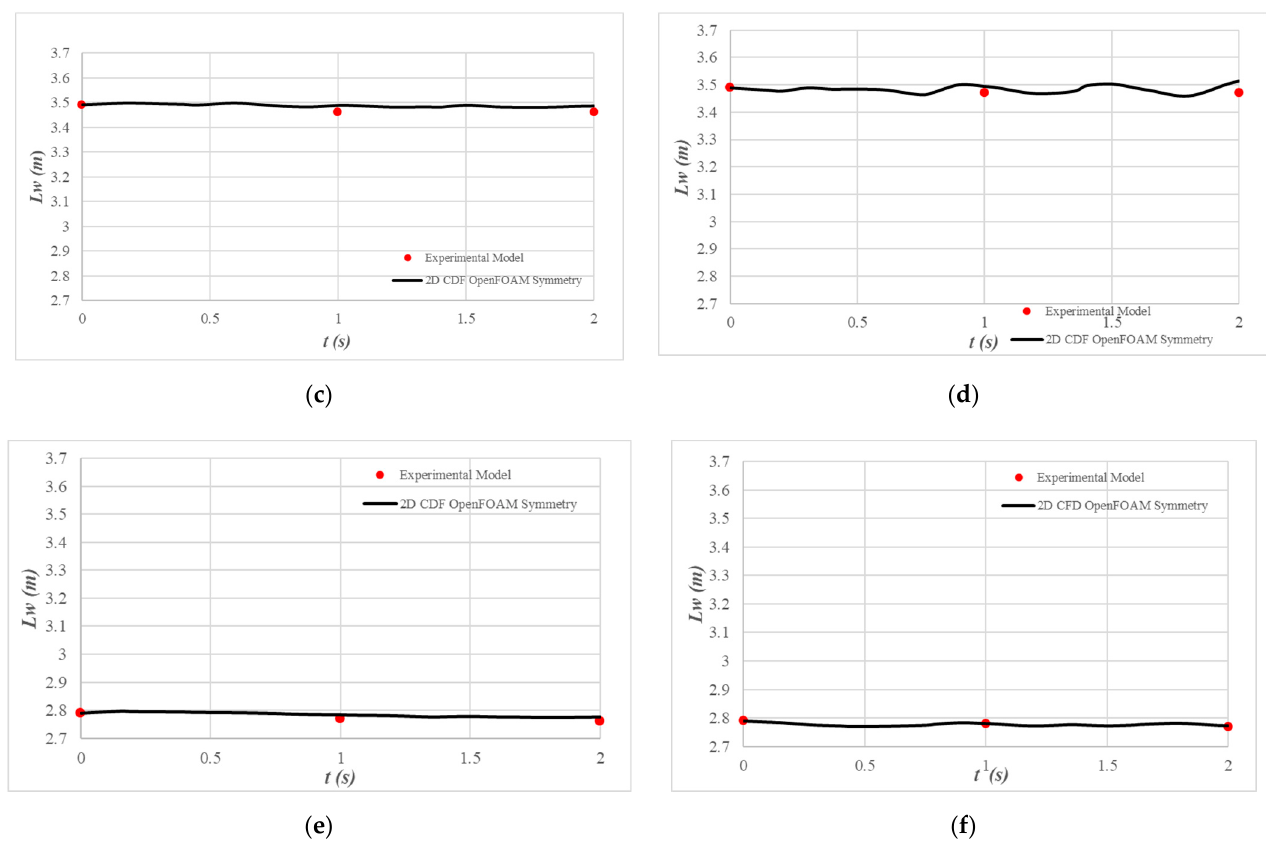
Figure 8. Analysis of the water column length in cases, with an initial air pocket length of 0.61 m, 0.28m and 0.98 respectively: ( a ) case A2; ( b ) case B5; ( c ) case A1; ( d ) case B5; ( e ) case A3; ( f ) case